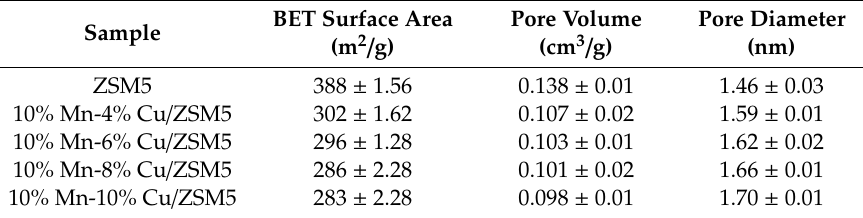
Table 1. Physical characteristics of ZSM5 and Mn-Cu / ZSM5 catalysts.